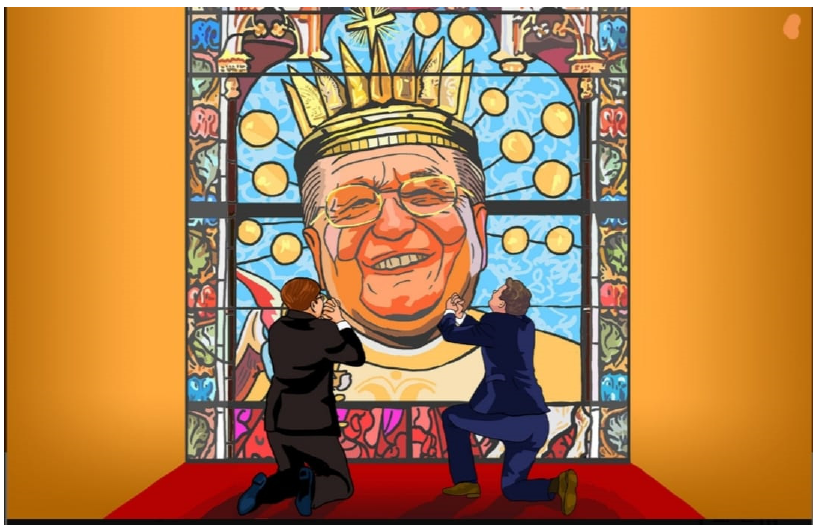
Figure 1. Marta Frej’s depiction of Father Tadeusz Rydzyk ( Polityka December 20/2020) (available online at https://www.polityka.pl/tygodnikpolityka/kraj/1982998,1,jak-ewangelizuje-ojciec-rydzyk.read, accessed on 5 September 2021).